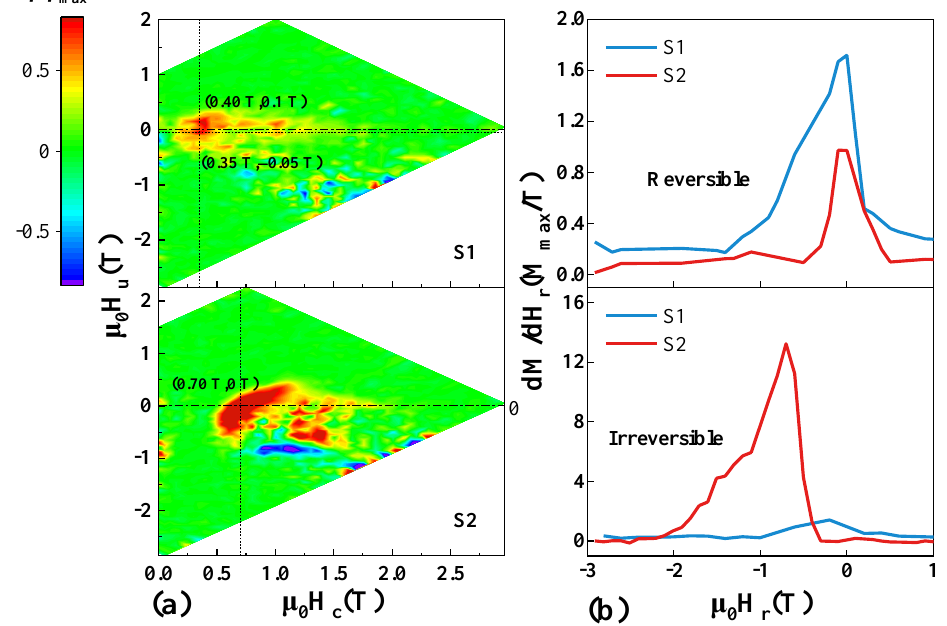
Figure 8. ( a ) FORC distributions of the S1 and S2 samples, in the µ 0 H u and µ 0 H c coordinate system; ( b ) extracted reversible and irreversible distributions, which correspond to the S1 and S2 samples.